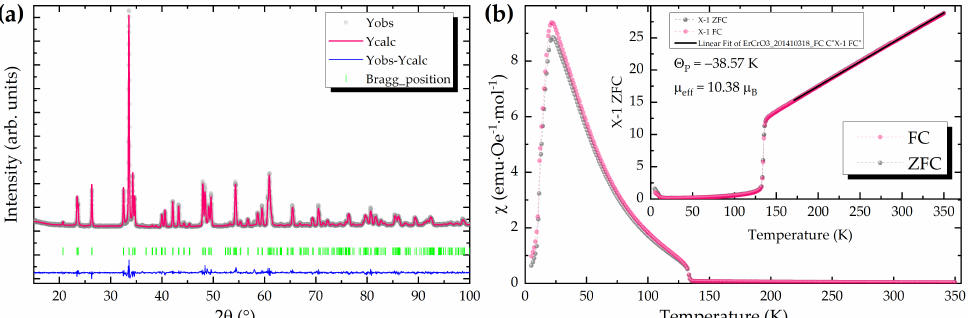
Figure 1. Structural and magnetic characterisation of ErCrO 3 sample. ( a ) Room-temperature pow- der XRD pattern of ErCrO 3 sample after the final heat treatment. Experimental pattern (dots), fit curve (pink line), and residual difference (blue line). Pnma -phase Bragg reflections (vertical bars). ( b ) ErCrO 3 magnetic susceptibility data as a function of temperature measured at 100 Oe, from 5 to 350 K. The inset depicts the reciprocal magnetic susceptibility in the same temperature range. In the reciprocal magnetic susceptibility data, the linear fit to the paramagnetic region is also